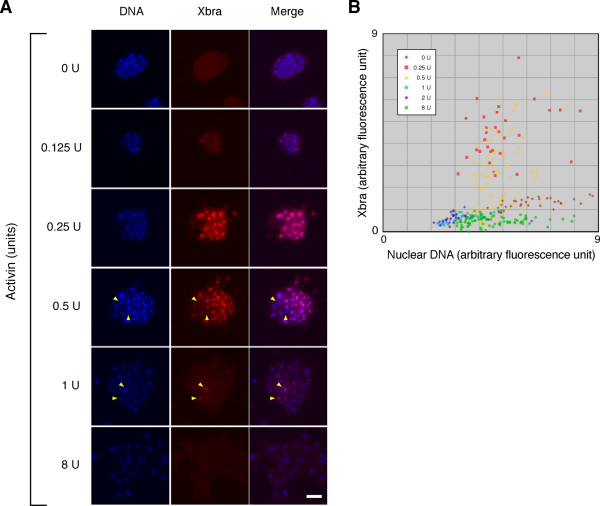
Heterogeneous expression of Xbra in Xenopus animal pole blastomeres. (A) Heterogeneous expression of Xbra in Xenopus animal pole blastomeres treated with uniform concentrations of activin. Dissociated Xenopus animal cap cells were treated with various concentrations of activin as indicated. The cells were fixed and stained by indirect immunofluorescence using an anti-Xbra antibody. Yellow arrowheads indicate the nuclei that are Xbra-negative among positive nuclei (0.5 U) or vice versa (1 U). Cells were counterstained with Hoechst33342 (DNA). Scale bar = 50 μm. (B) Plot of Xbra versus DNA fluorescences. The fluorescence was quantified as described in Methods.